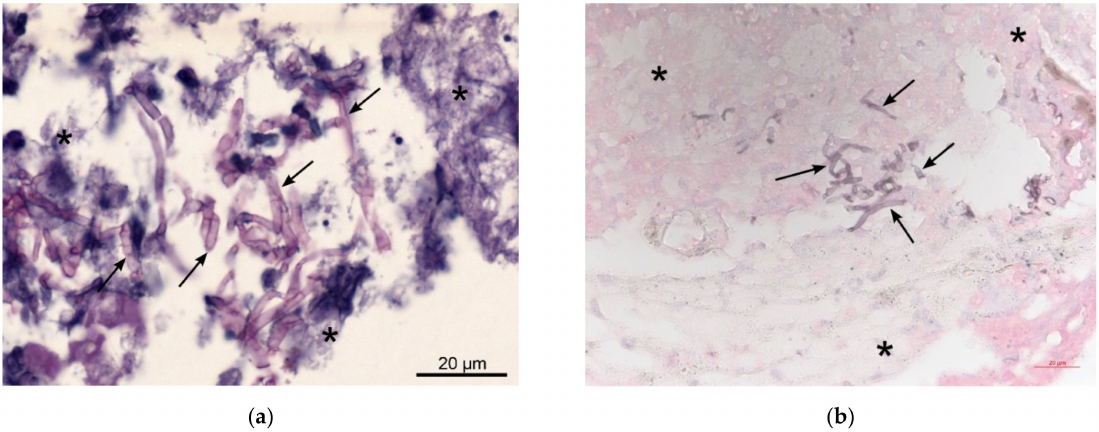
Figure 3. Pathological images of brain biopsy ( a ) The brain biopsy shows necrotic brain tissue (star) with mostly narrow, septated hyaline mold hyphae (arrow) without specific branching pattern or conidiation in tissue, suggesting hyalohyphomycosis without characteristic findings indicative of aspergillosis or scedosporiosis. Periodic acid–Schiff (PAS) staining; ( b ) Grocott’s Methenamine silver staining.